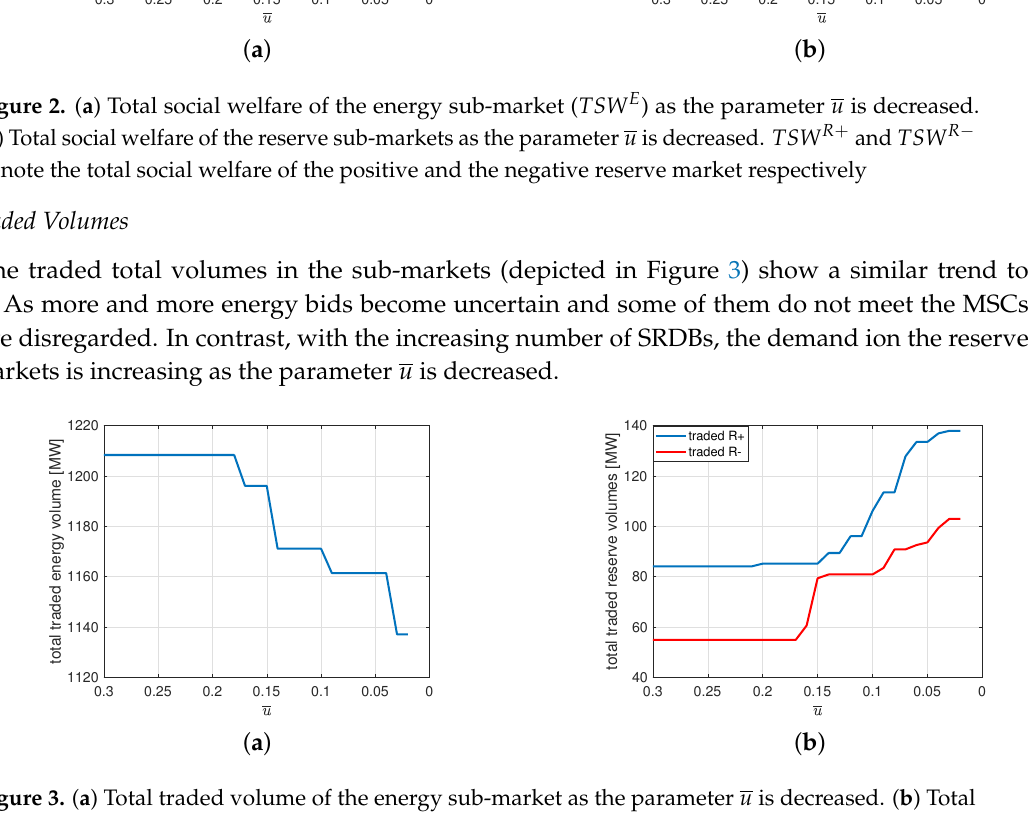
Figure 3. ( a ) Total traded volume of the energy sub-market as the parameter u is decreased. ( b ) Total traded volumes of the reserve sub-markets as the parameter u is